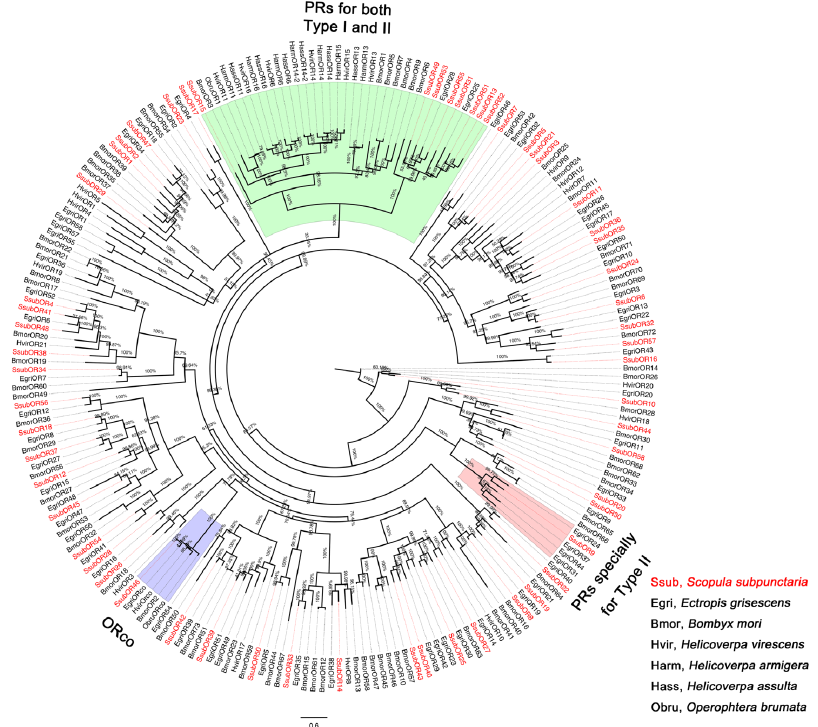
Figure 1. Phylogenetic analysis of SsubORs with other lepidopteran insects. The percentages on the branches show the bootstrap values. The group in purple was classified as “Orco”. The group in green was classified as “PRs for both types I and II”. The group in red was classified as